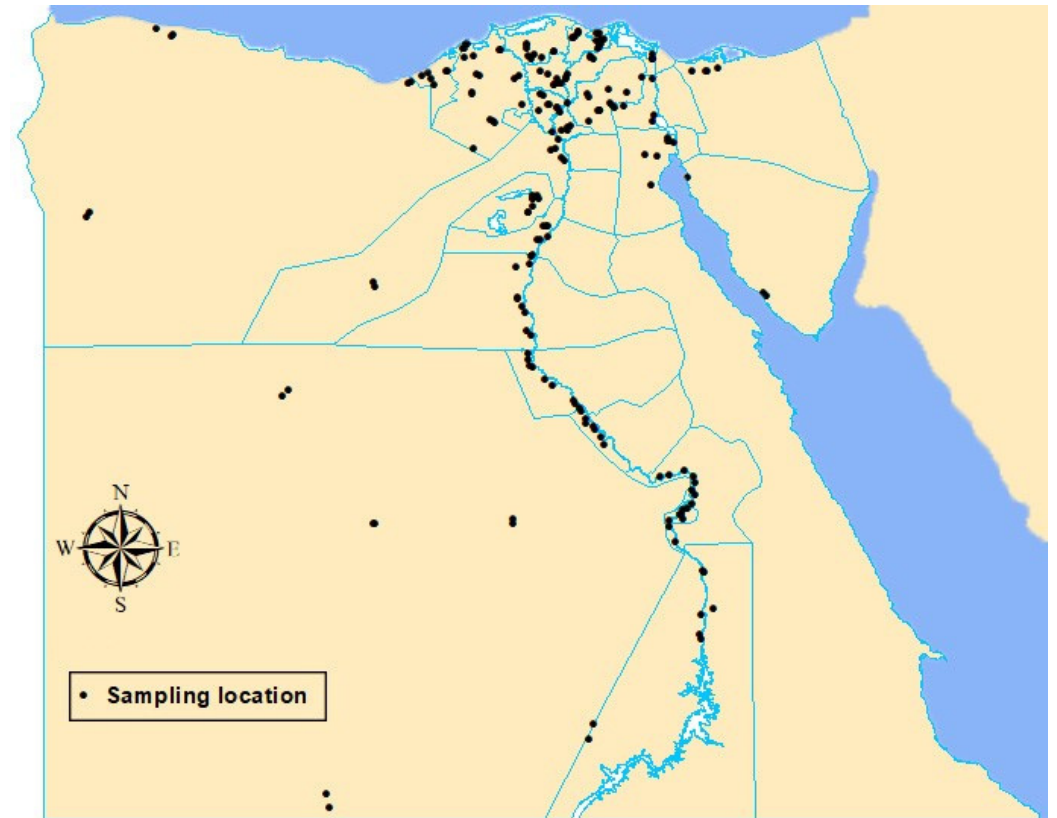
Figure 1. Wheat grain sampling locations (black dots) in the 25 wheat-growing governorates of Egypt.